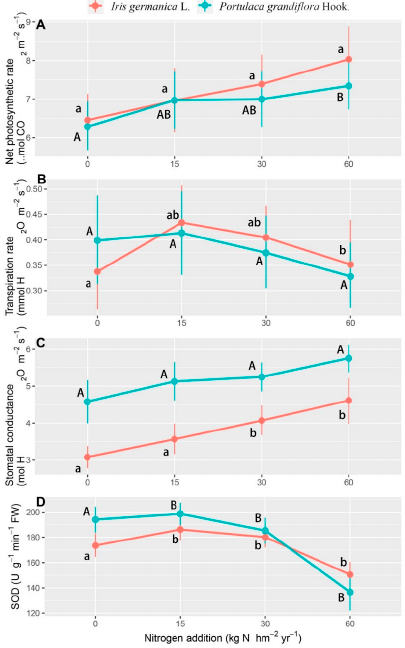
Figure 4. The response of the net photosynthetic rate (Npr) ( A ), transpiration rate (Tr) ( B ), stomatal conductance (g s ) ( C ), and SOD activity ( D ) to nitrogen application rate in the form of aerosols in Iris germanica L. and Portulaca grandiflora Hook. over sampling dates. Values are means with 95% boot- strapped confidence intervals (CI). Differences are significant at α = 0.05, when the CI does not over- lap the subsequent mean. Upper and lower case letters indicate significantly different results for Portulaca grandiflora Hook. and Iris Germanica L. on applied nitrogen concentration, respectively.